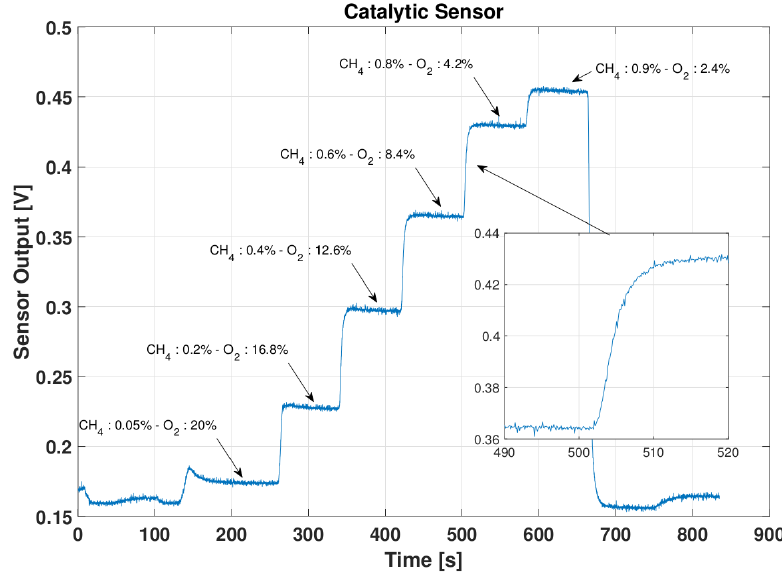
Figure 2. Catalytic Sensor